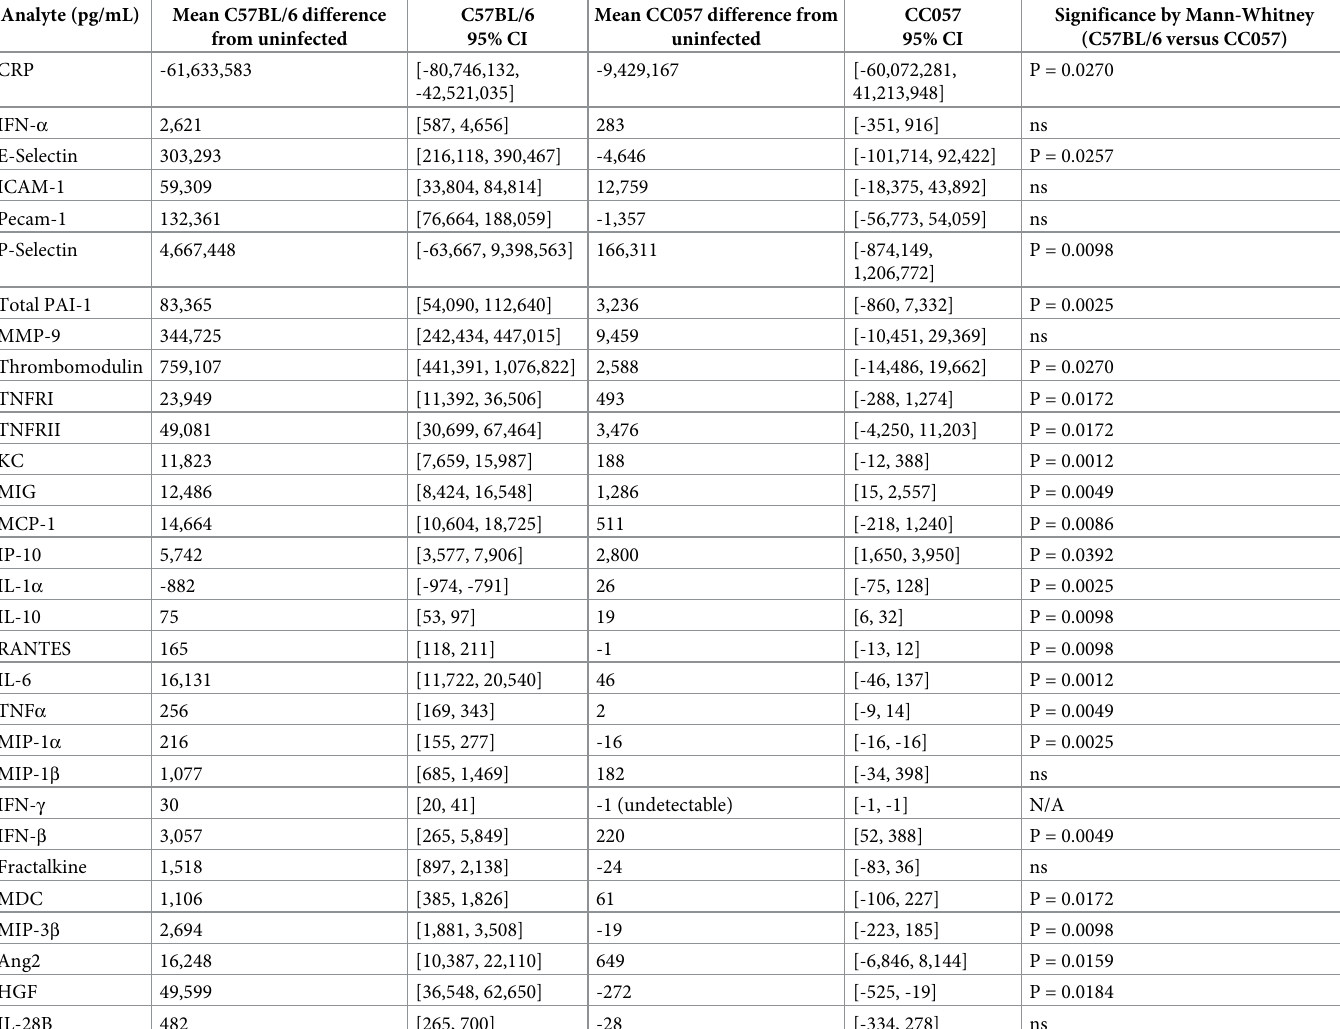
Table 1. C57BL/6 and CC057 analyte mean and 95% Confidence Interval (CI) at 3 dpi as a function of difference from the uninfected mean. Analyte (pg/mL) Mean C57BL/6 difference from uninfected